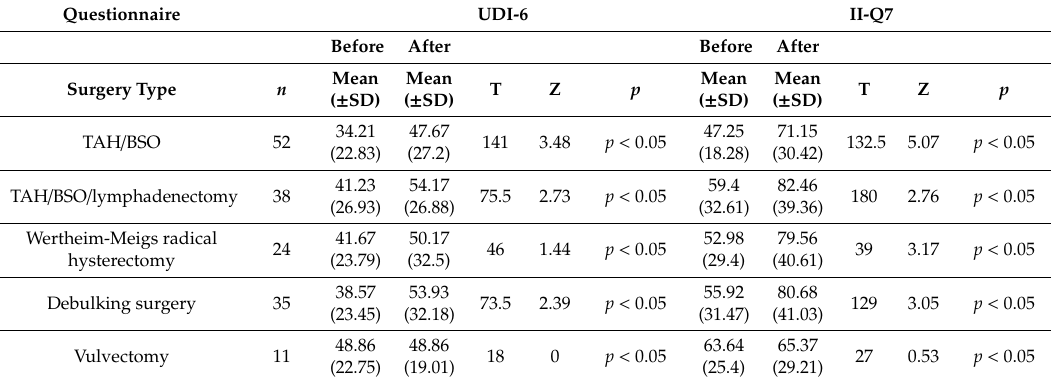
Table 6. Impact of the mode of surgical treatment performed on the prevalence of urinary incontinence symptoms and impact on patients’ everyday life (UDI-6 and II-Q7 questionnaires) (Wilcoxon’s signed-rank